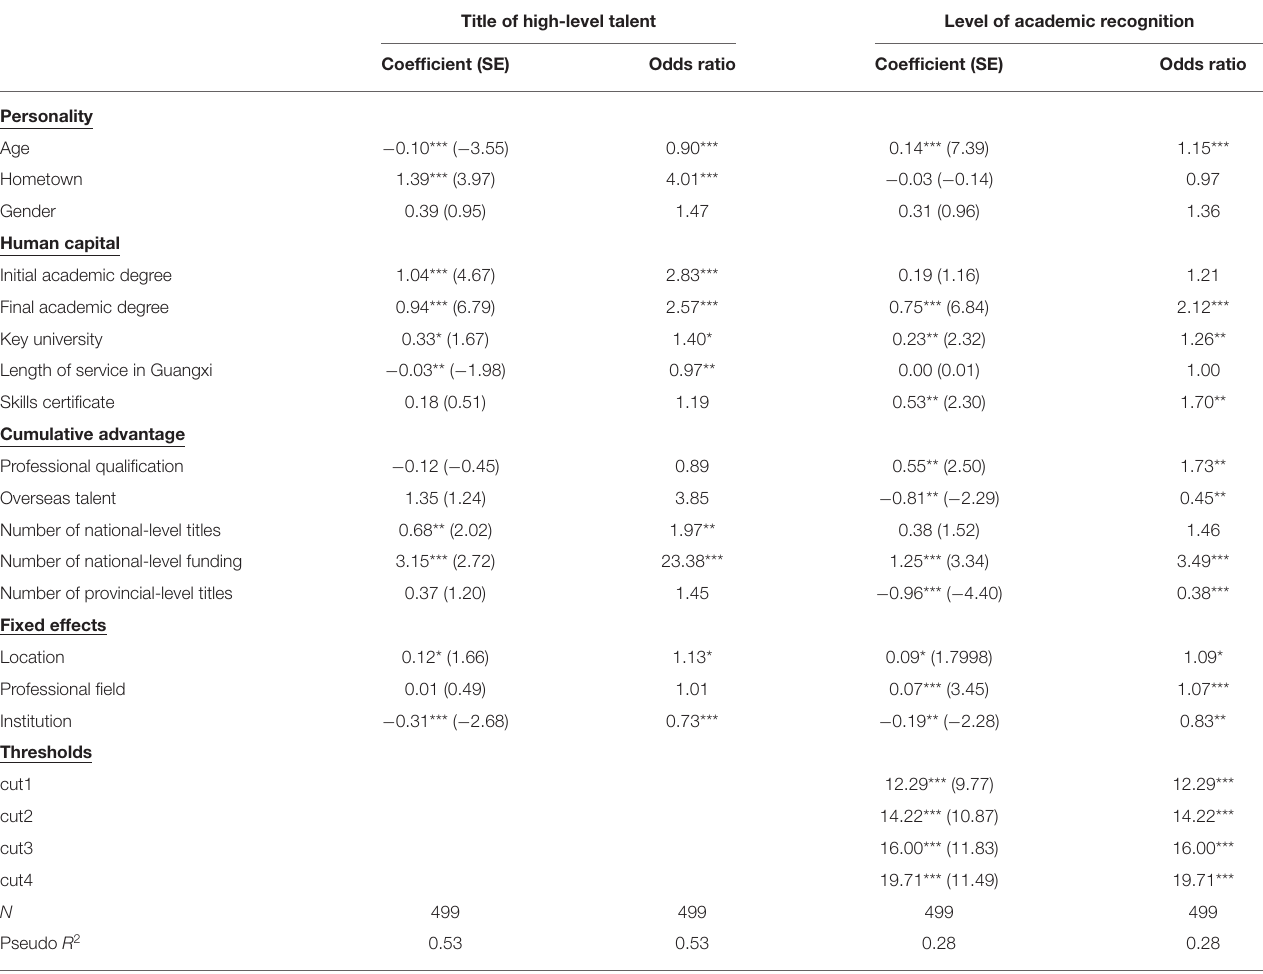
TABLE 3 | Regression results of related